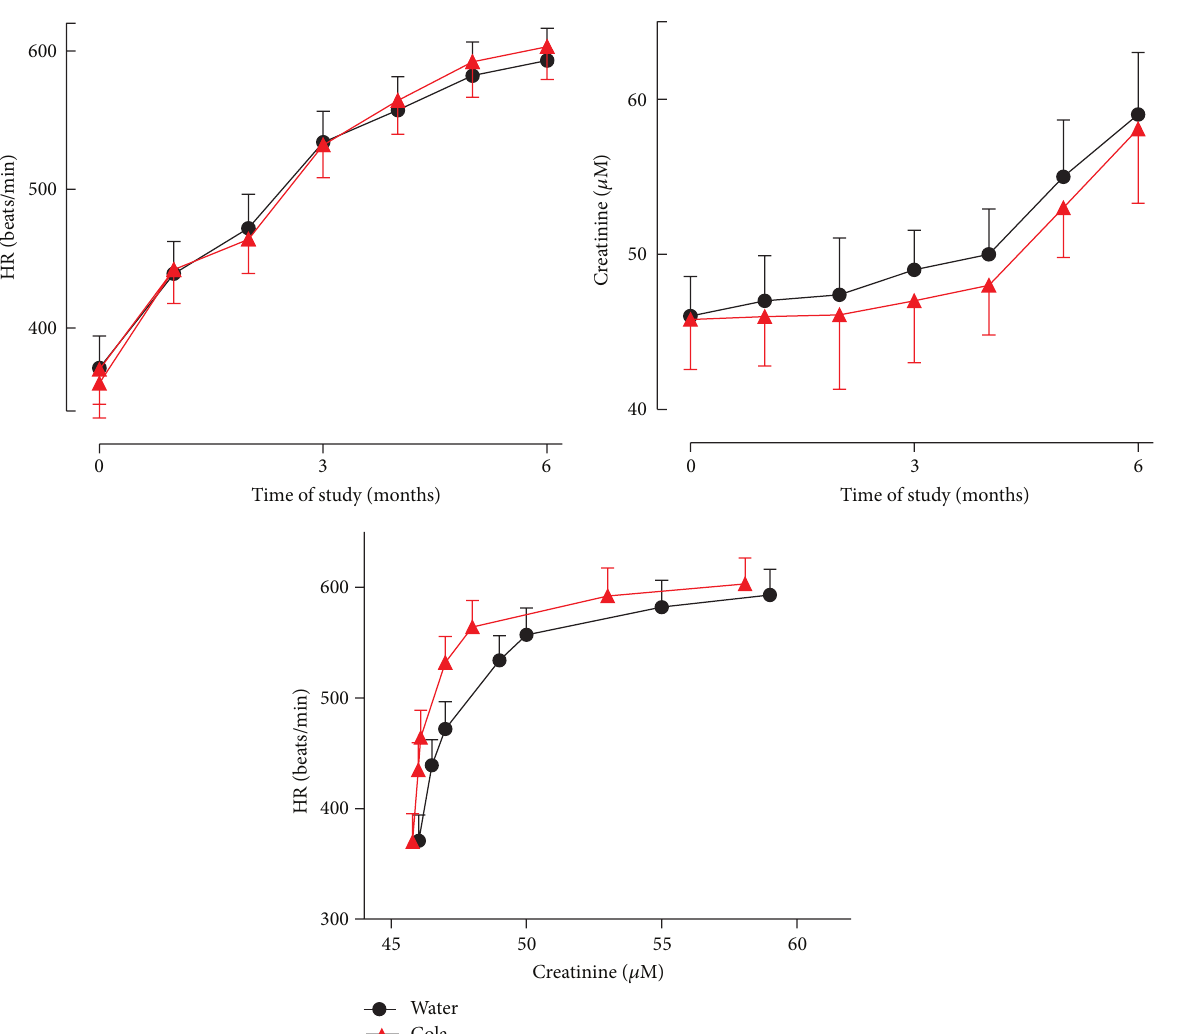
Figure 4: Heart rate (HR), creatinine, and their relationship over the time of study. Cola drinking did not affect HR, creatinine, or HR- creatinine association over time.